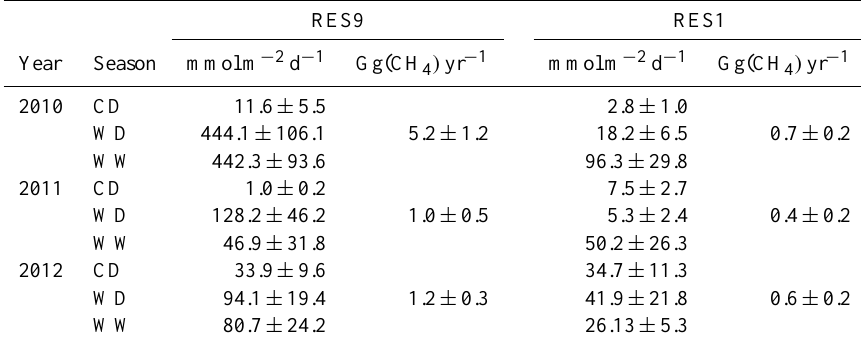
Table 1. Depth-integrated methane oxidation rates (mmolm − 2 d − 1 ) and annual amount of oxidized CH 4 (Gg(CH 4 ) yr − 1 ) at stations RES9 and RES1 of the Nam Theun 2 Reservoir. The depth-integrated CH 4 oxidation rates are given for each season: cold dry (CD), warm dry (WD), and warm wet (WW) for each